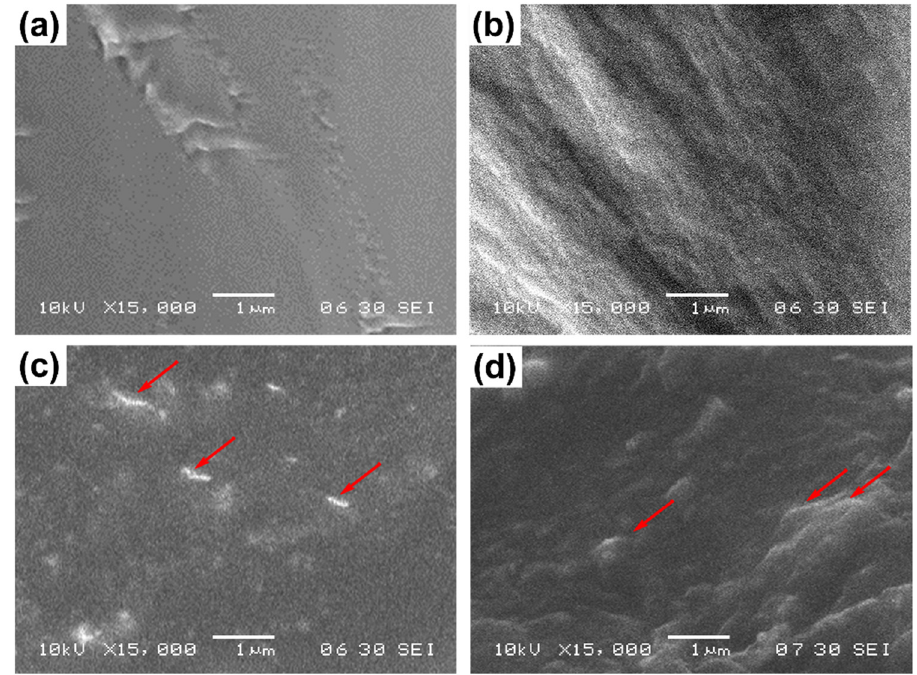
Figure 5: SEM micrographs of ( a ) PU, ( b ) PU/PEMA IPN, ( c ) 0.5 wt% GR - PU/PEMA and ( d ) 1.0 wt% GR -